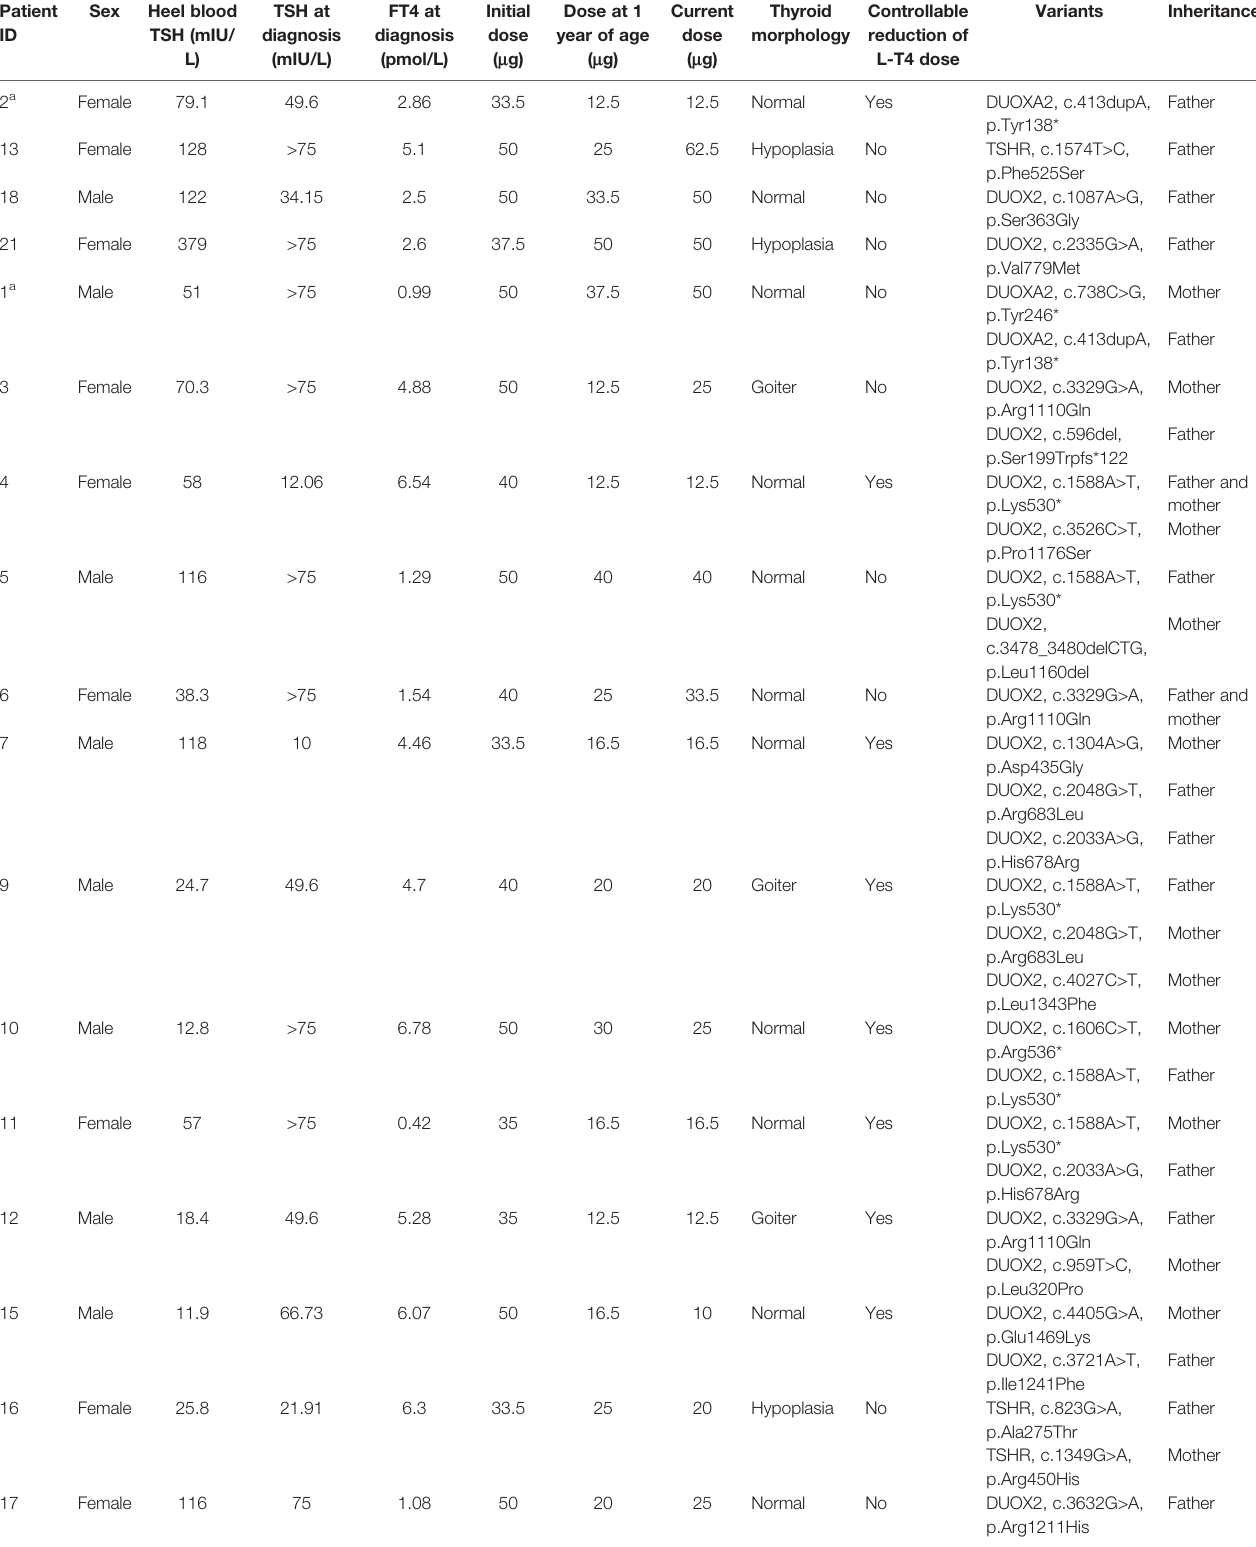
TABLE 3 | Clinical description and variants in patients with monoallelic, biallelic, and oligogenic variants. Patient